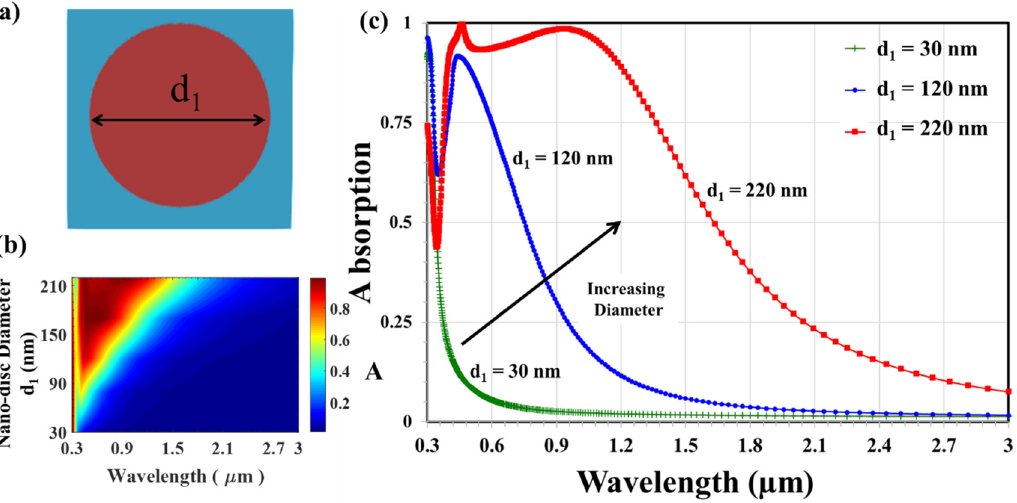
Figure 2. ( a ) Top view of nano ‐ disc cap array and absorbance spectra ( b , c ) of the proposed plas ‐ monic absorber. plasmonic